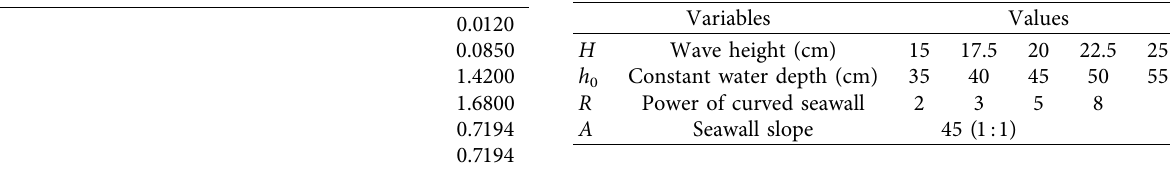
Table 2: The values of wave heights and water depths in different test cases.